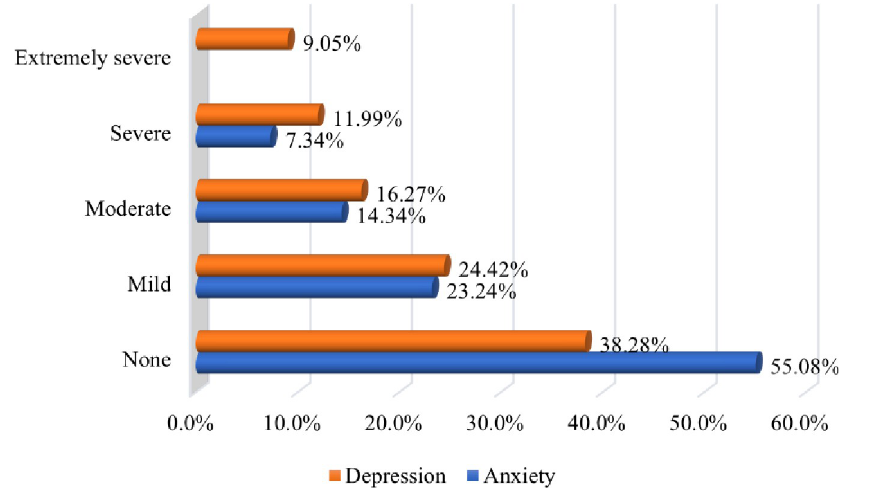
Fig 1. Participants’ anxiety and depression